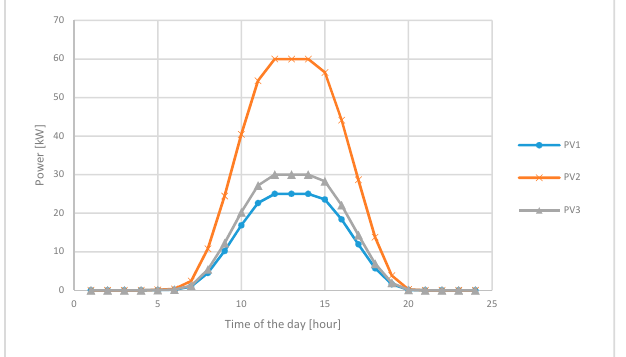
Energies 2017 , 10 , 1336 Figure 5. Renewable generation photovoltaic (PV) profile. Figure 5. Renewable generation photovoltaic (PV) profile. Figure 5. Renewable generation photovoltaic (PV) profile.